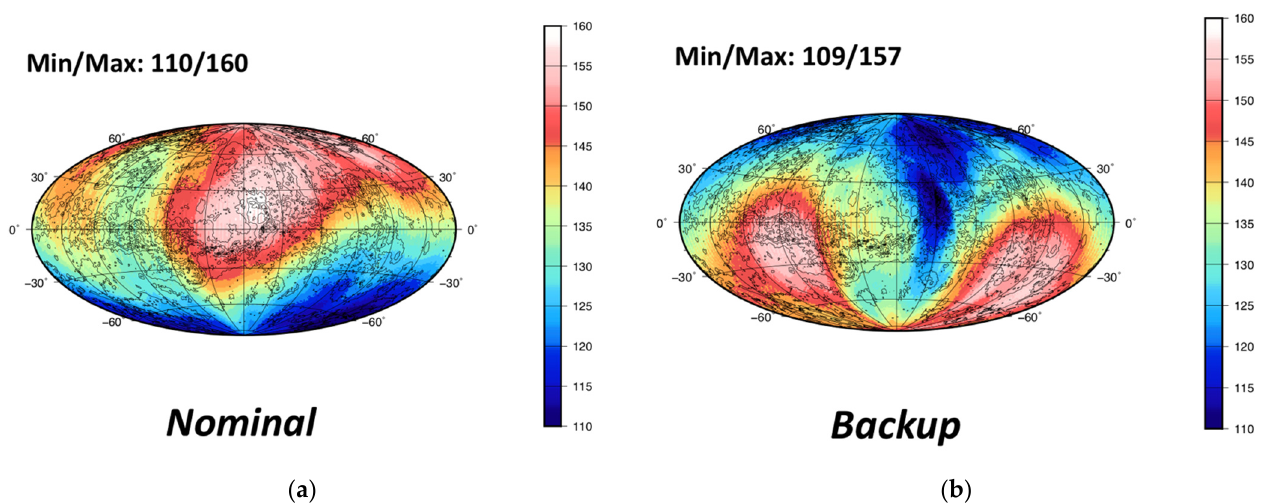
Figure A2. Expected EnVision maps of the gravity field degree strength (in Hammer-Aitoff projection) for ( a ) the nominal scenario and ( b ) a backup scenario presently under study in phase A of the EnVision mission. The associated spatial resolution map of the nominal scenario is shown in Figure 1. The isocontours of the Venus topography [43] are shown in the background.